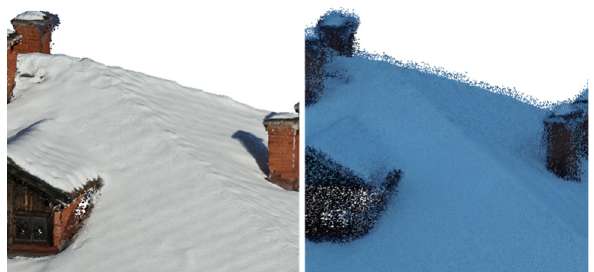
Figure 10. Comparison between P1 (on the left) and L1 (on the